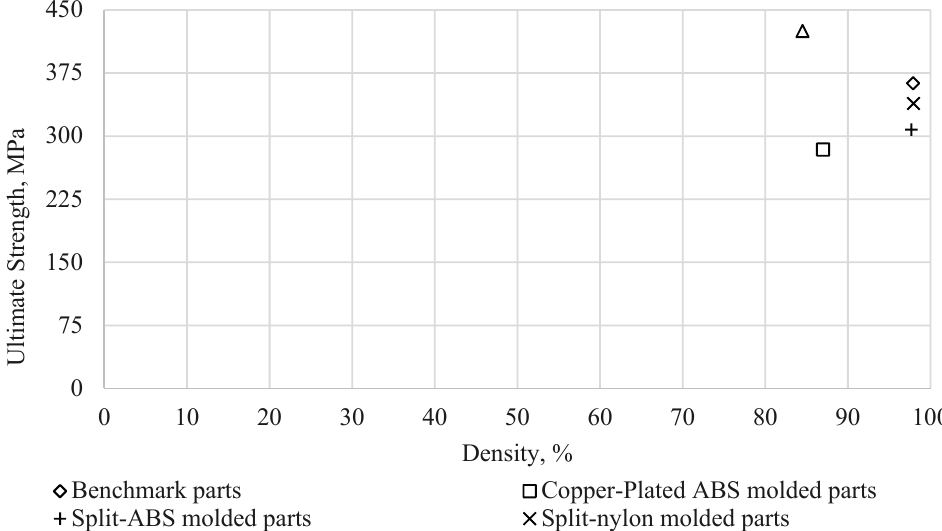
Figure 16. Comparison of tensile strength with density.